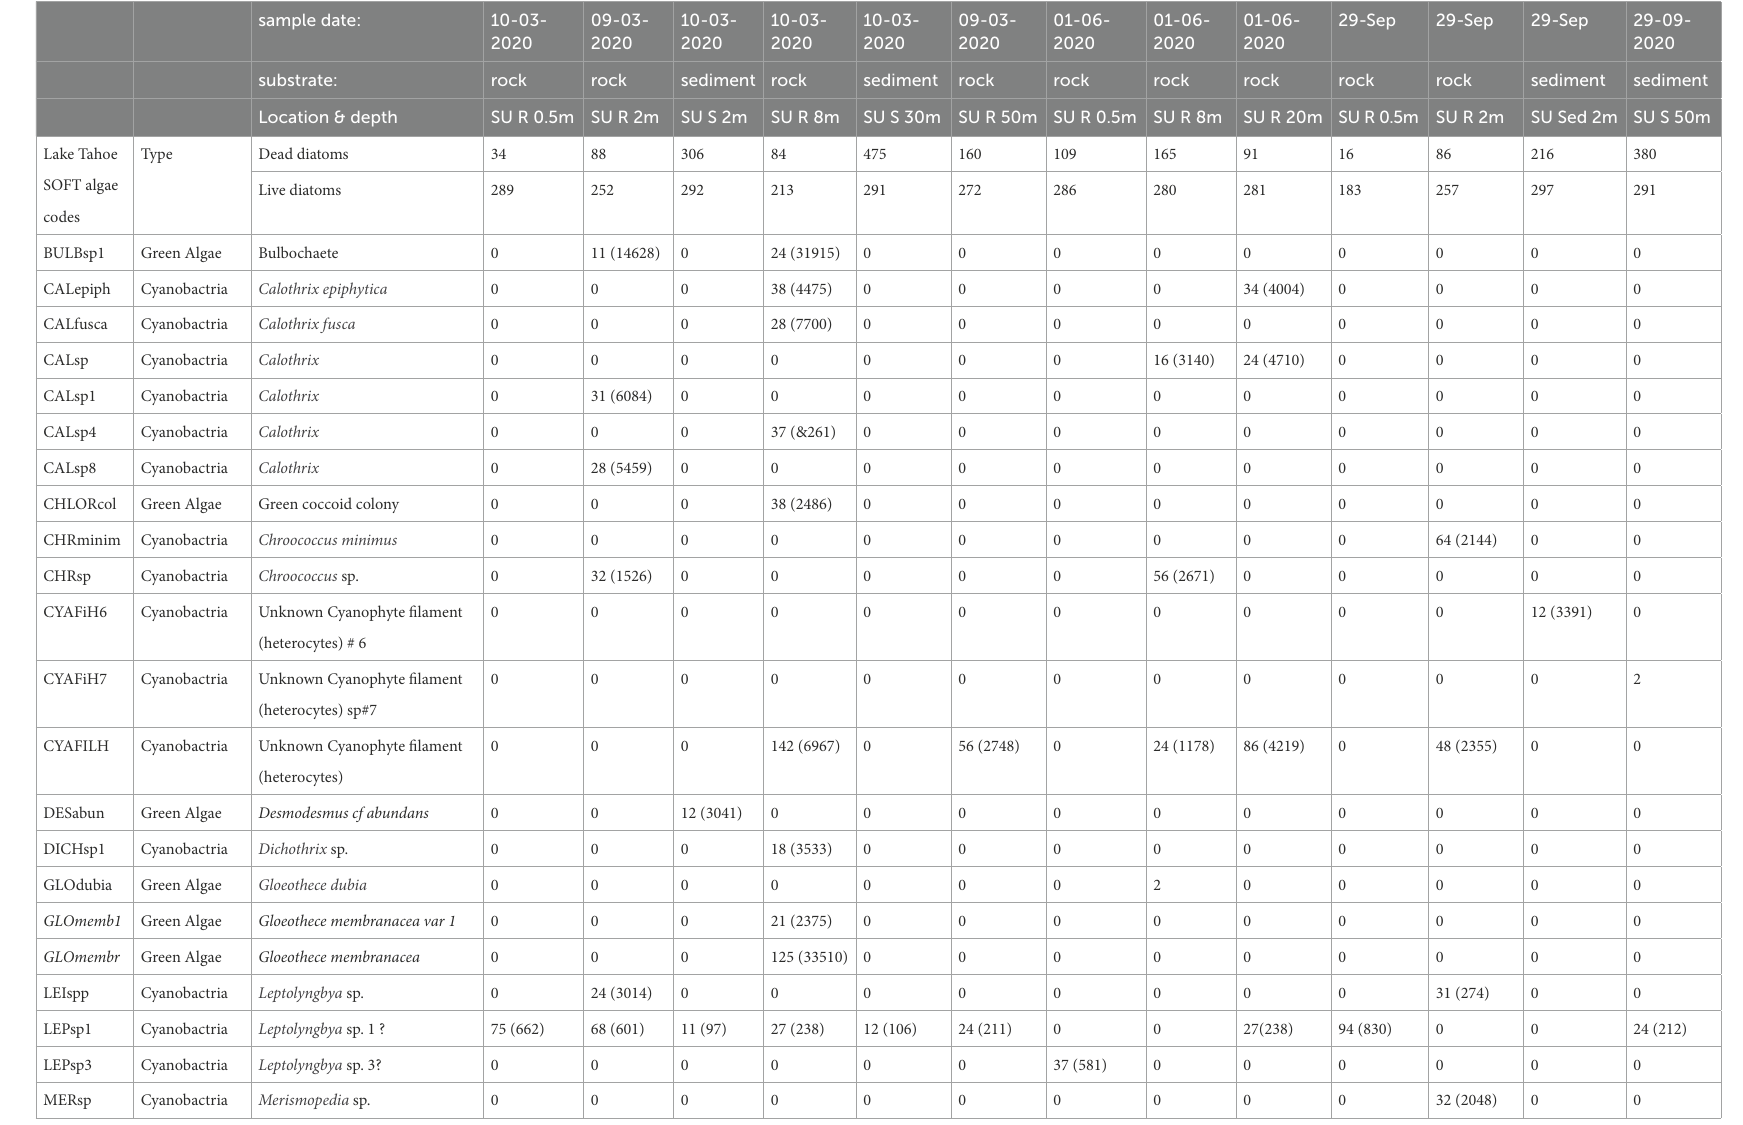
TABLE 3 Summary counts of algae and their habitats from Lugol’s